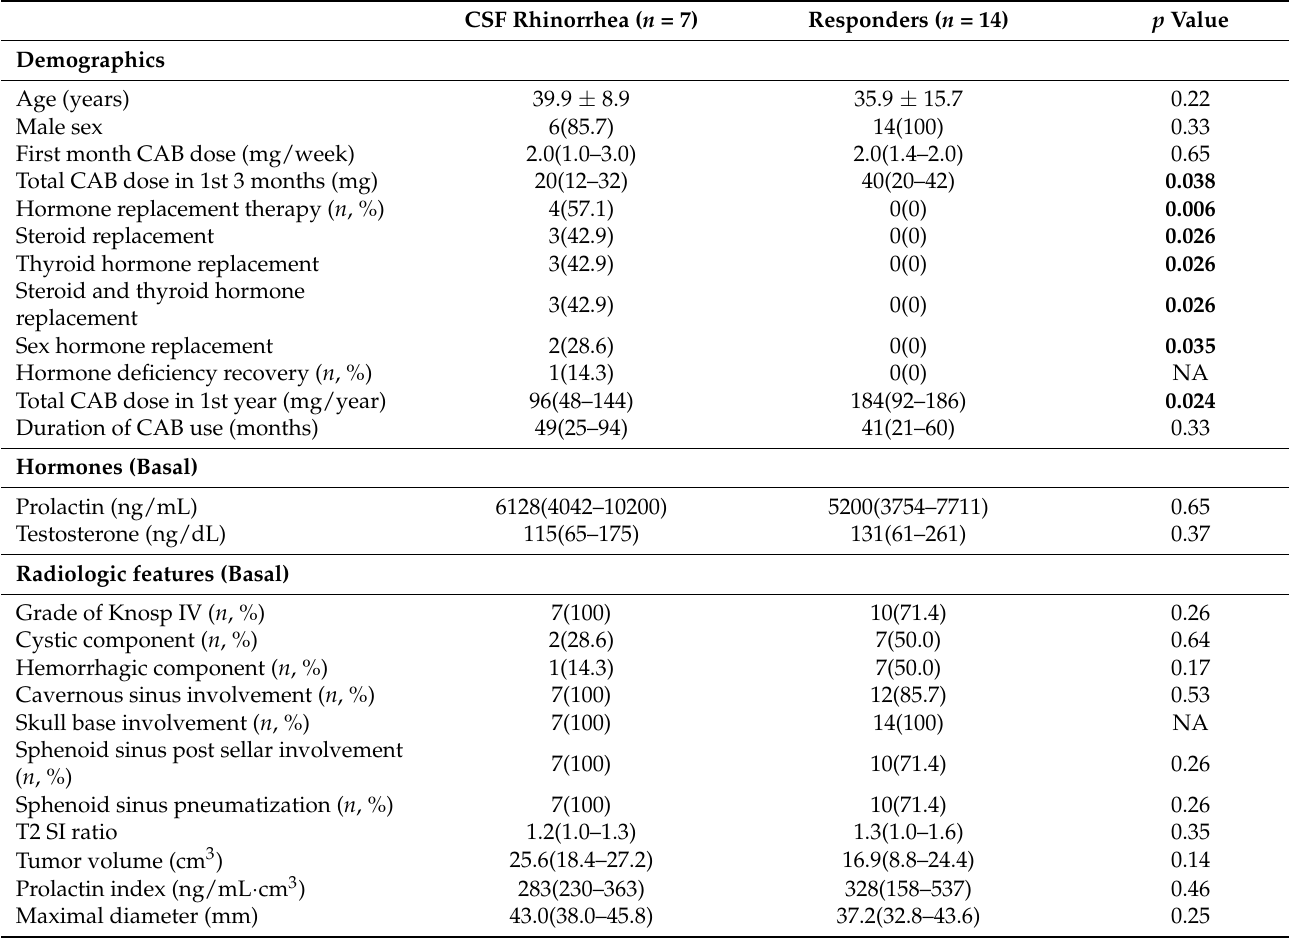
Table 3. Clinical characteristics of patients with CSF rhinorrhea compared to hormonal and radiologic responders by propensity score